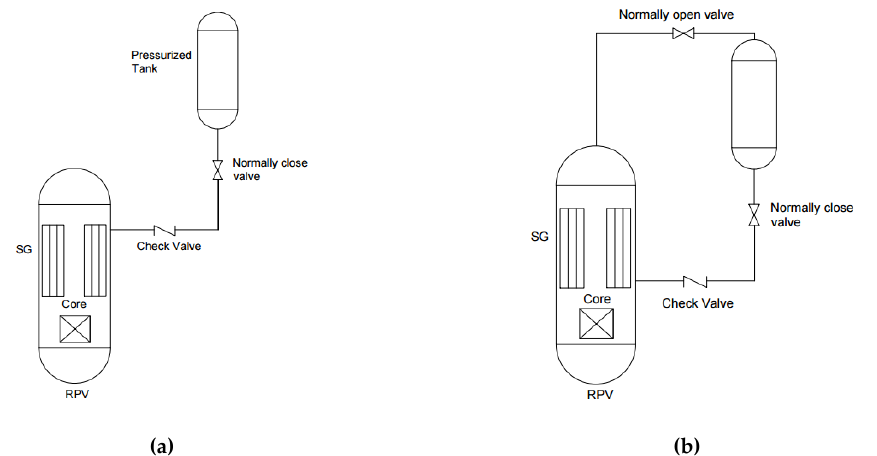
Figure 3. ( a ) One time injection system, ( b ) natural circulation (NC)-based injection system.